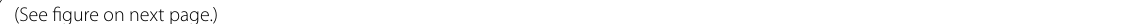
(See figure on next page.) Fig. 7 Morphometric relationships, weight/test diameter (tW/Dt), weight/test height (tW/Ht) and test height/test diameter (Ht/Dt) of the studied Diadema setosum population (data were pooled over islands and surveyed